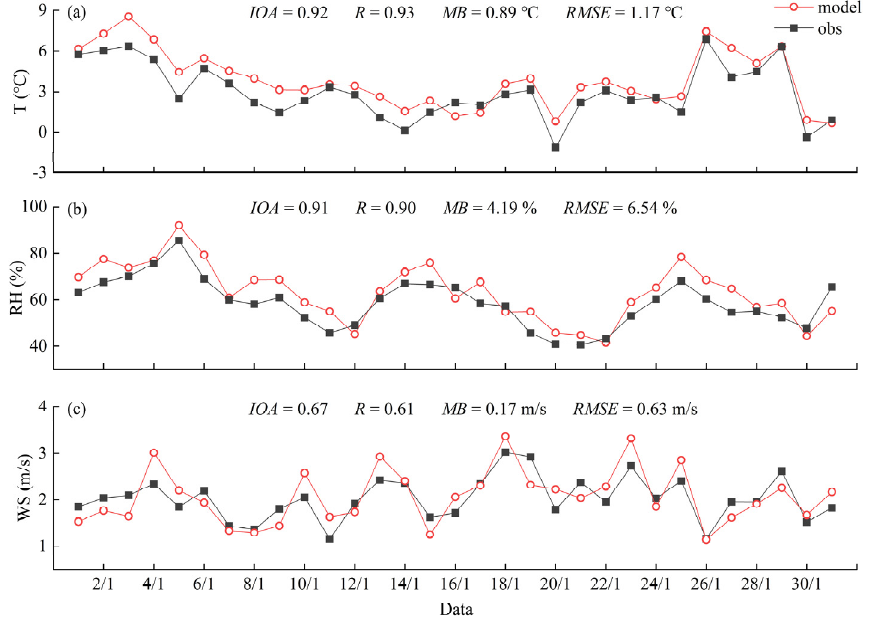
Figure 3. The time series of daily simulated and observed average temperatures ( a ), average relative humidity ( b ), and average wind speeds ( c ) at meteorological sites in Xi’an in January 2019.